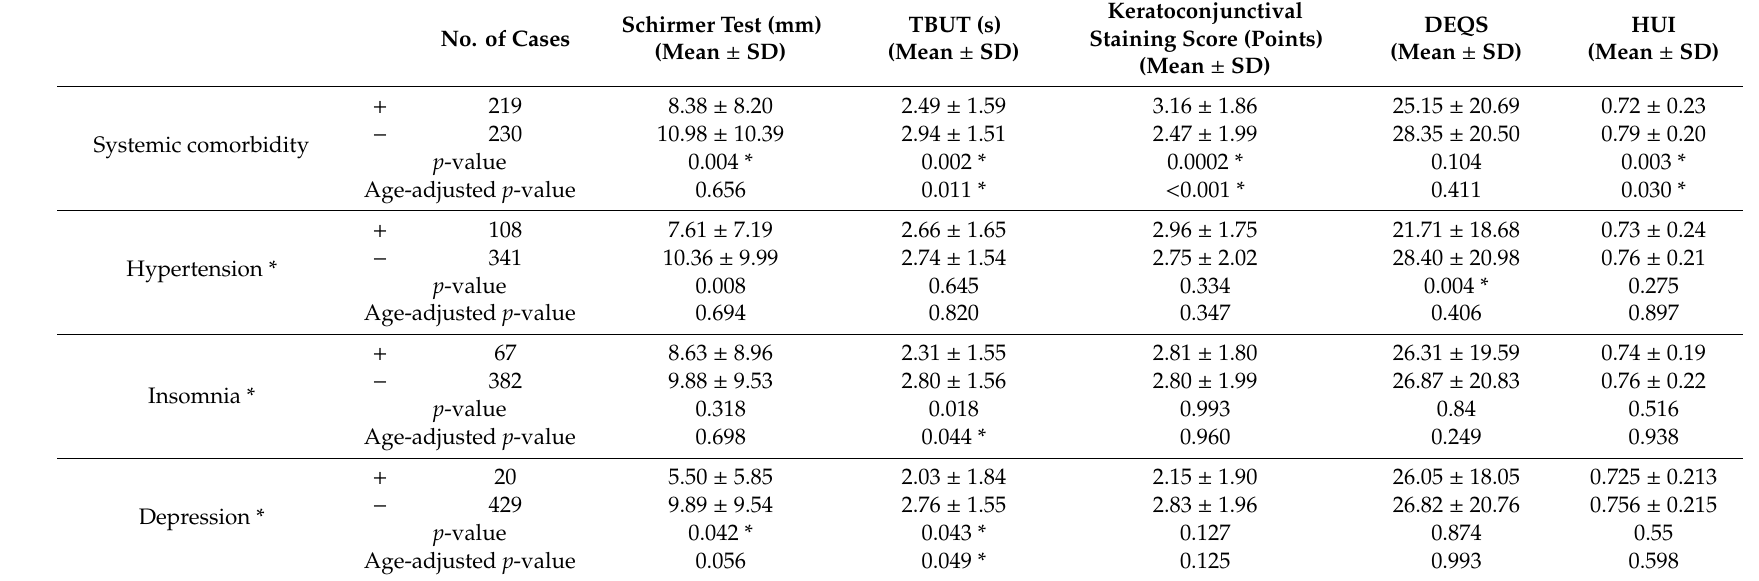
Table 3. Systemic comorbidities and dry eye